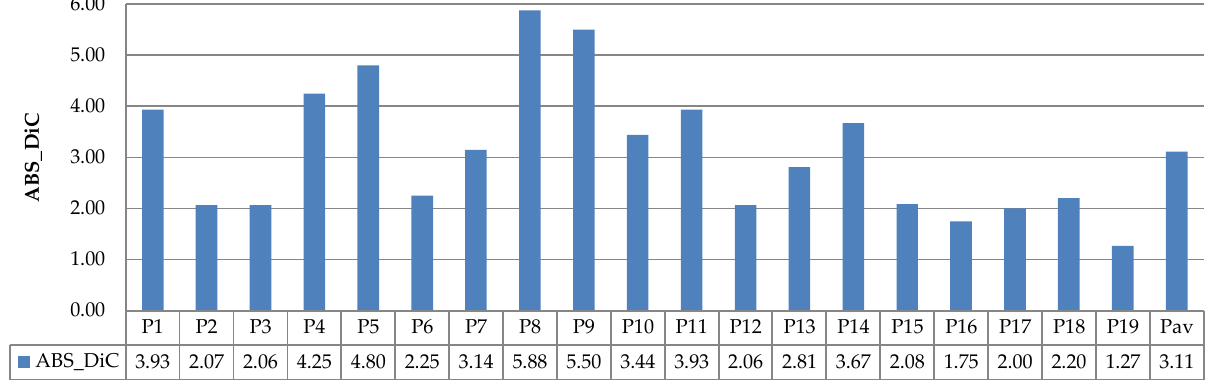
Figure 22. Results of DiC measurements using Ara2012.